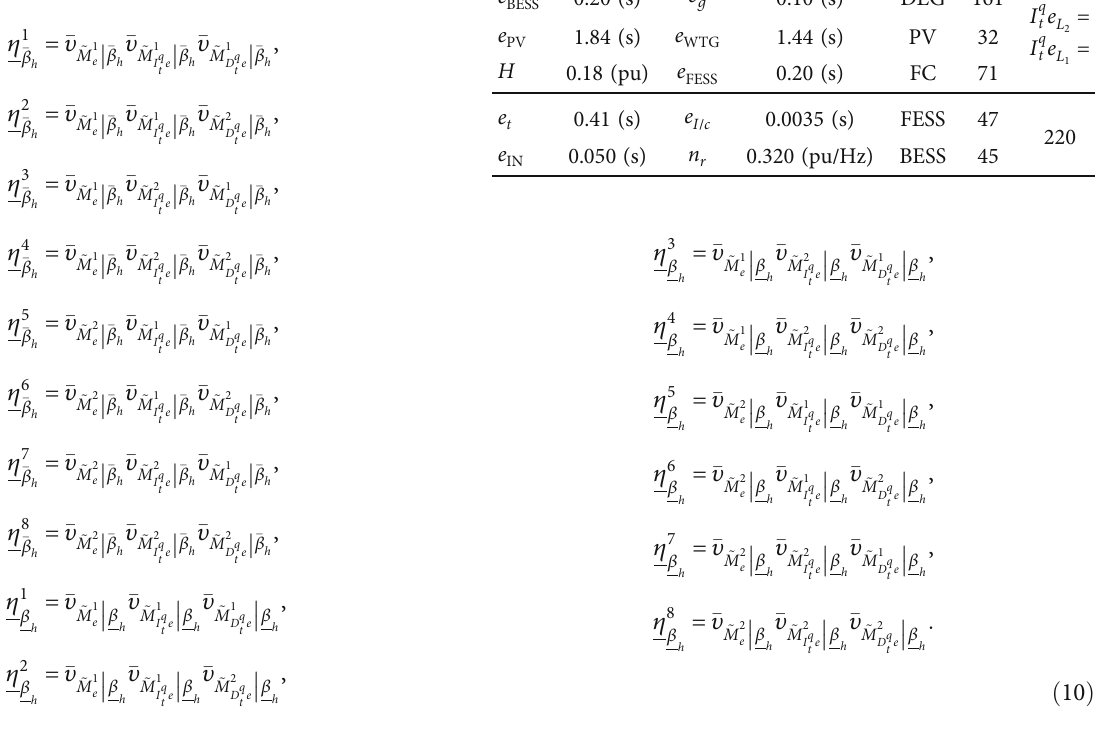
The lower fi ring degree of rules at upper/lower slice levels is obtained as